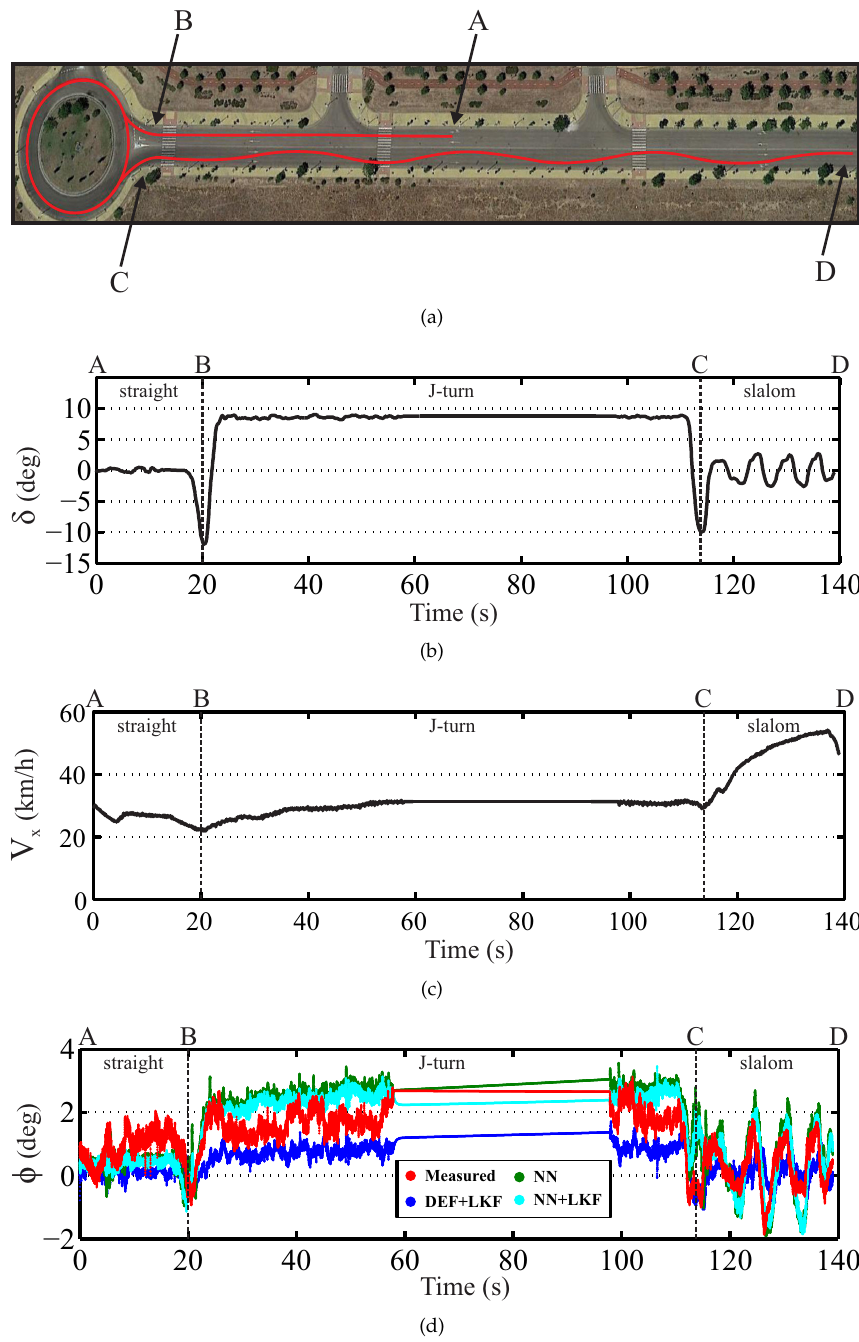
Figure 11. Experimental results for J-turn and slalom maneuvers (red points: measured; blue points: DEF + LKF; green points: NN; cyan points: NN + LKF): ( a ) the real environment and the vehicle trajectory, ( b ) the steering wheel angle profile, ( c ) the longitudinal vehicle speed profile and ( d ) the real and estimated roll